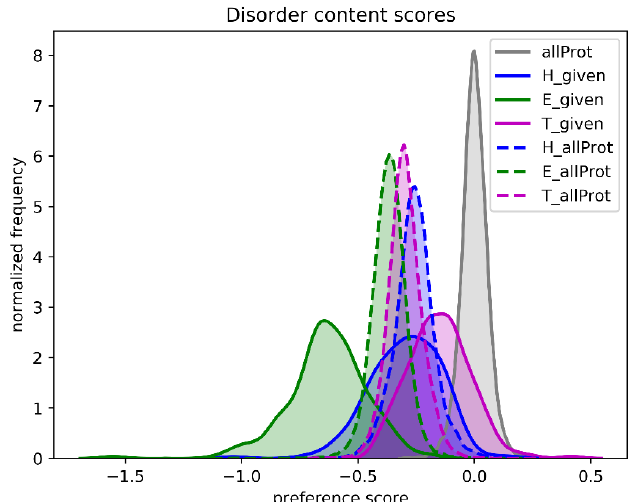
Figure 9. SSN scores for intrinsically disordered protein regions assuming one secondary structure. The grey curve represents the SSN scores for the full set of 22,405 proteins. The SSN scores of these 22,405 proteins were determined assuming each protein was either one long Helix (dashed blue), Strand (dashed green), or Turn (dashed magenta). Similarly, solid lines (in the same colors) show the SSN scores determined for 225 natively unfolded protein regions assuming one single secondary structure for that whole region.